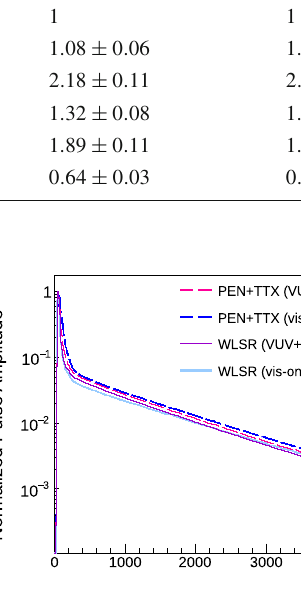
at the presence of impurities, likely due to the outgassing of a PTFE filler present in the cryostat, as discussed in